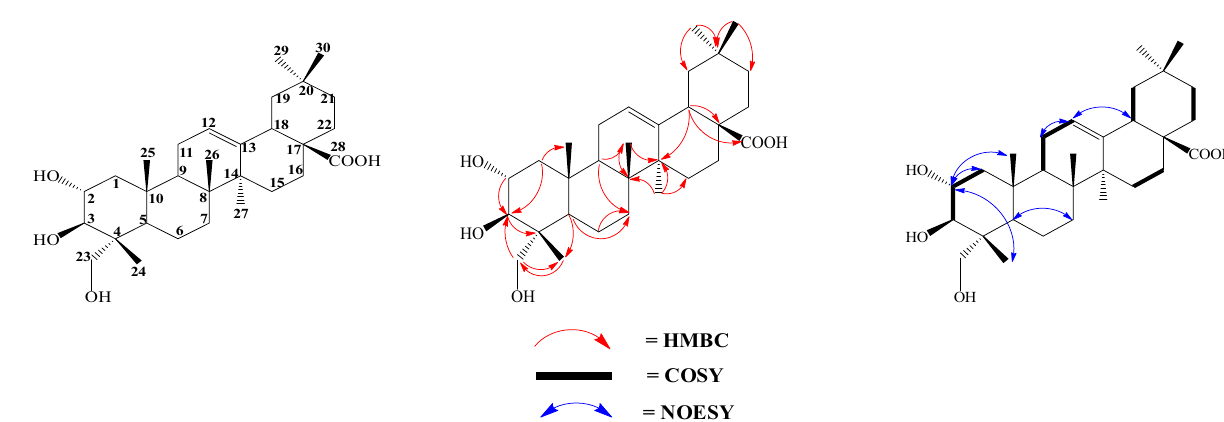
Figure 2: DQF - COSY, NOESY, and HMBC correlations of arjunolic acid from S. aqueum